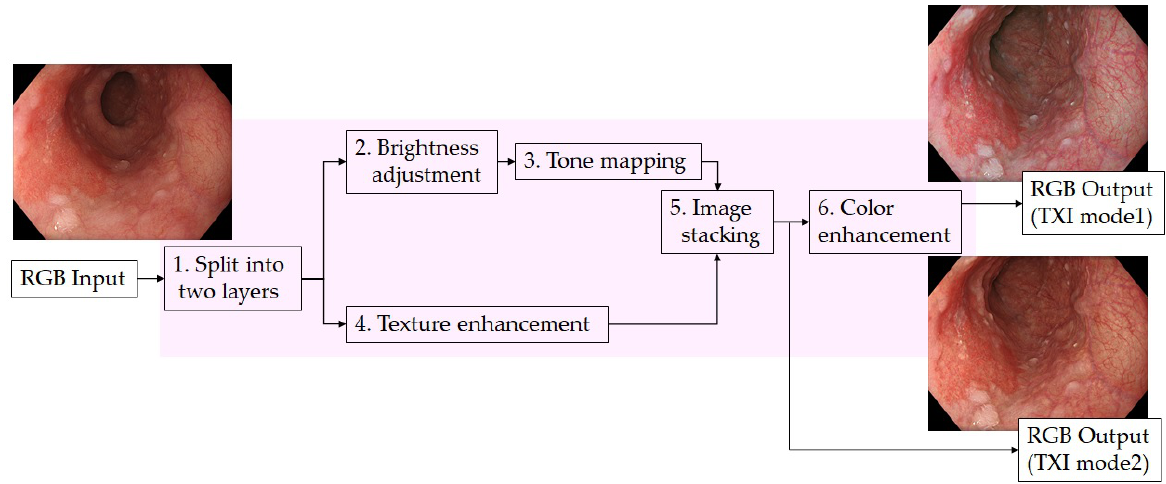
Figure 1. The algorithm of texture and color enhancement imaging (TXI).